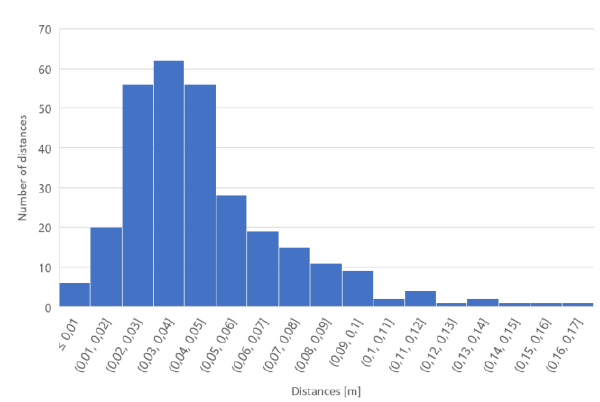
Figure 7. Histogram of the distances in space between newly calculated points and calculated points from former